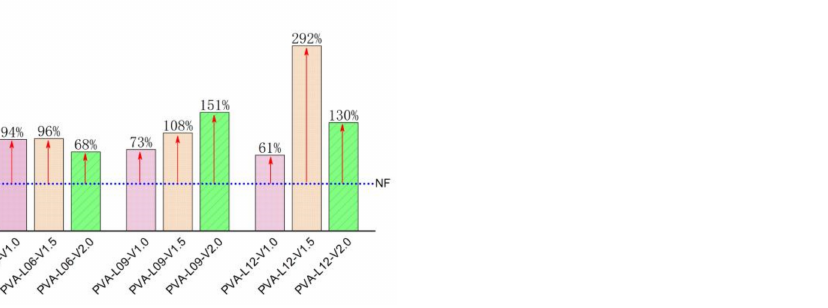
Figure 17. The growth rate of the ultimate tensile strain of PVA-reinforced coral cement-based composites.